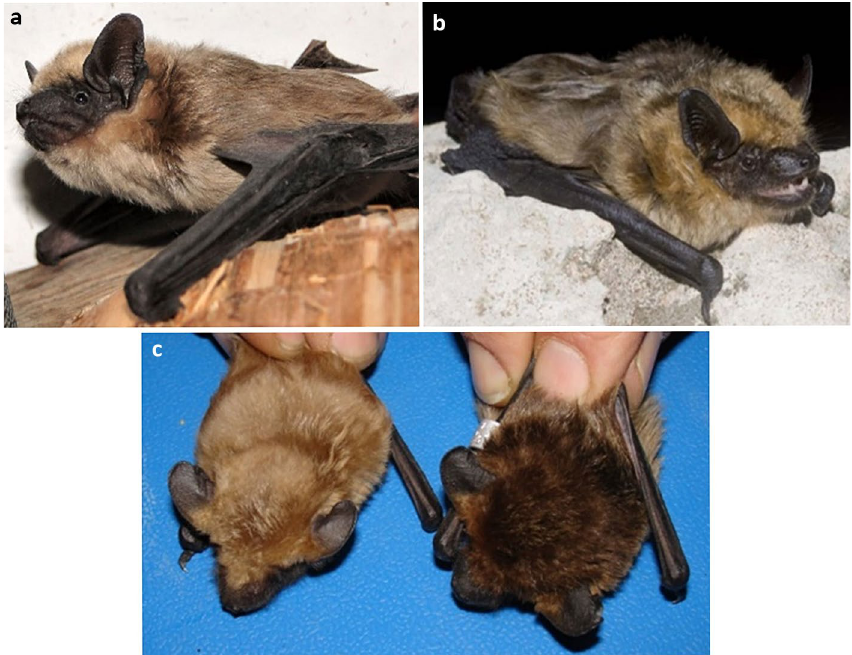
Figure 1. Colour differences between bat groups. Photographic representation of hair colour of representative specimens of both parental species groups: ( a ) allopatric Eptesicus isabellinus, ( b ) allopatric E. serotinus and ( c ) sympatry E. isabellinus — on the left - and sympatric E. serotinus - on the